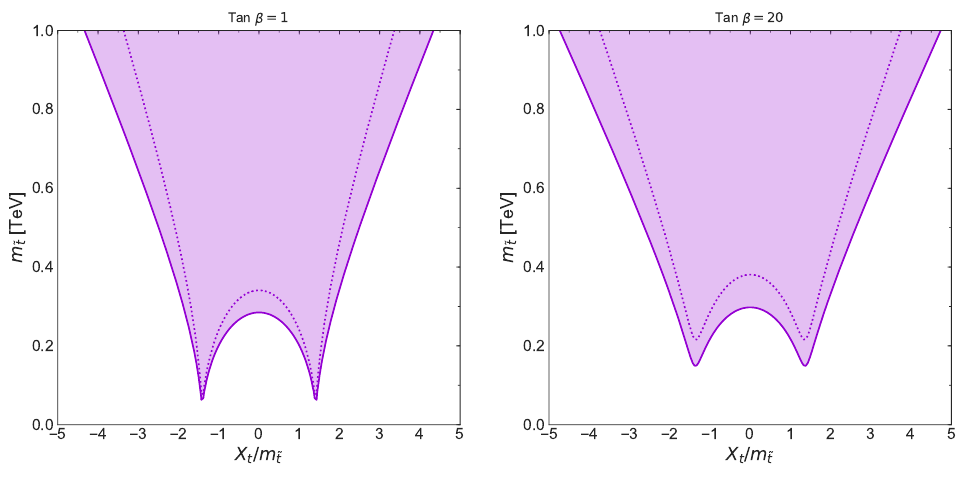
,). The two panels , m ˜ t m ˜ t